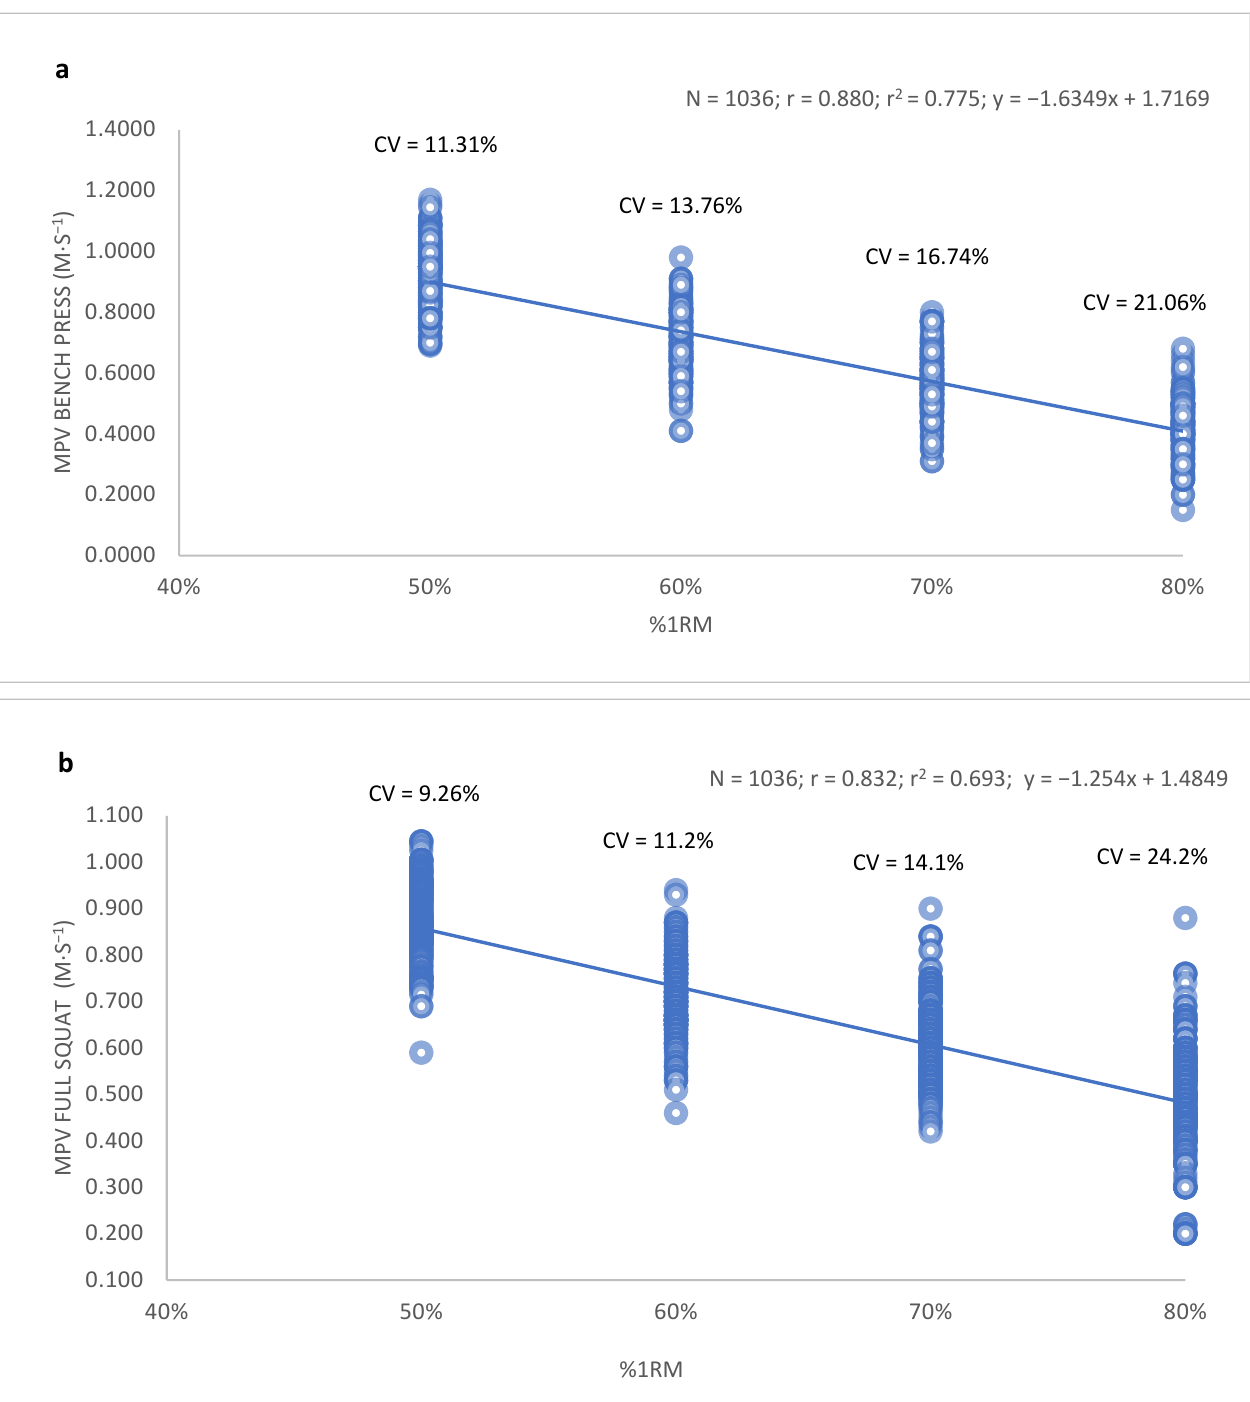
Figure 1. Relationship between MPV and relative load (%1RM) in the group of women for ( a ) the bench press and ( b ) full squat movements. Data were obtained from the values of the mobilization velocity of the isoinertial progressive load carried out in the sample of 96 young women .